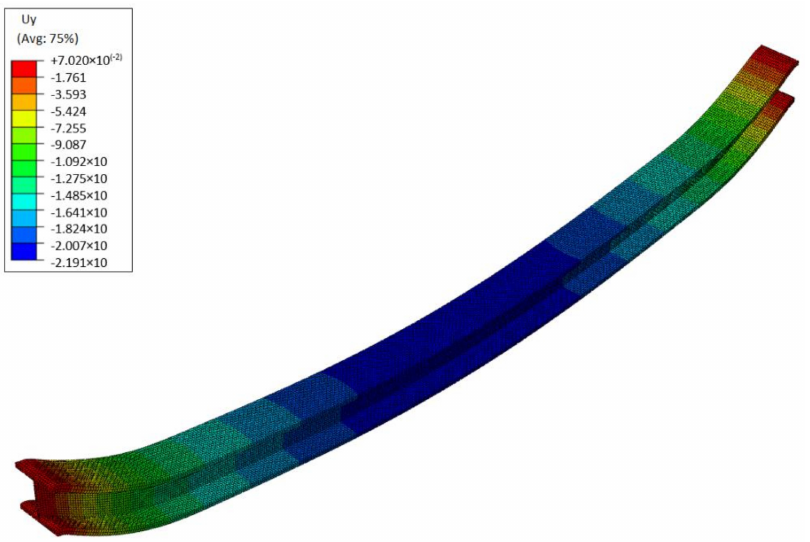
Figure 17. Vertical displacements map for the steel beam at the end of the deformation process.